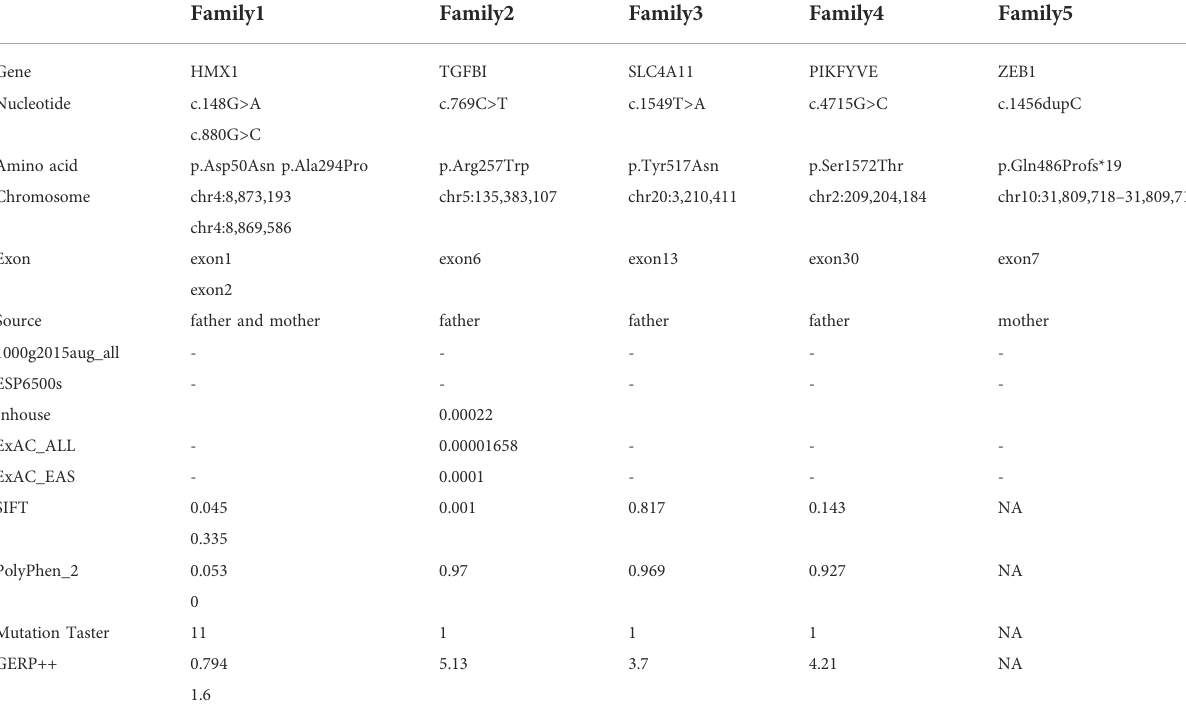
TABLE 1 Pathogenicity analyses of variants and bioinformatics analysis of variants in the 5 Chinese families with